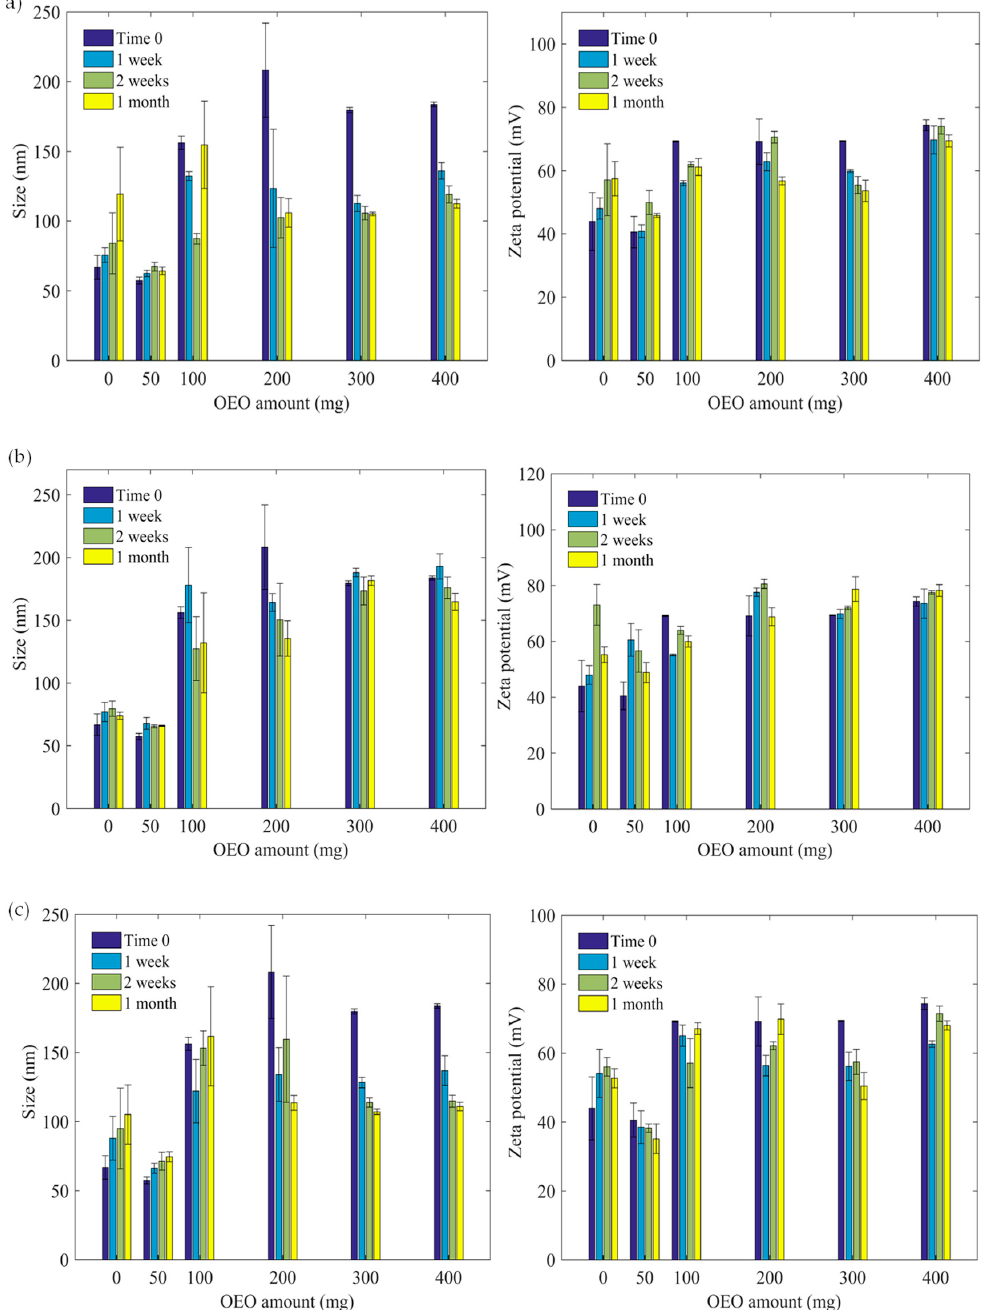
◦ C for orange essential oil, ( b ) 4 ◦ C, ( c ) 40 ◦ Figure 3. ( a ) Size and zeta potential at 25 °C for orange essential oil, ( b ) 4 °C, ( c ) 40 °C. Figure 3. ( a ) Size and zeta potential at 25